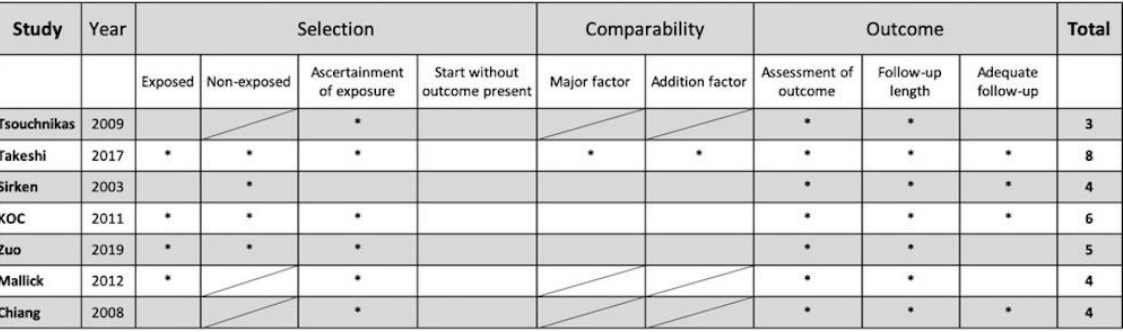
Figure 3. Risk of bias of randomized controlled trials.